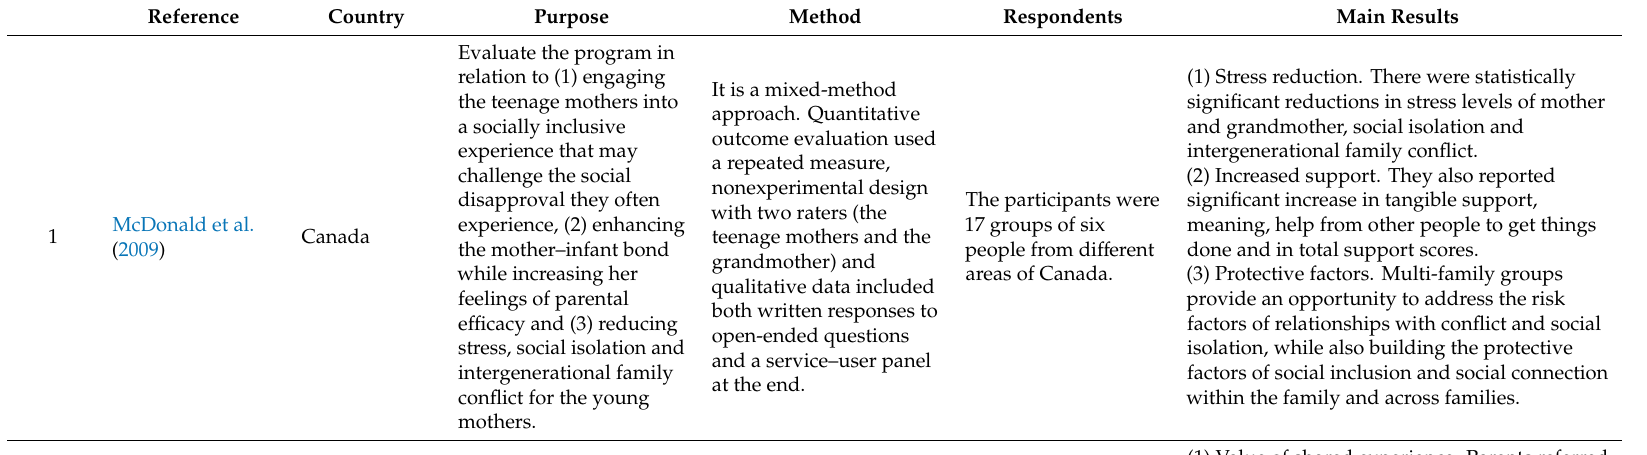
Table 2. Characteristics of the